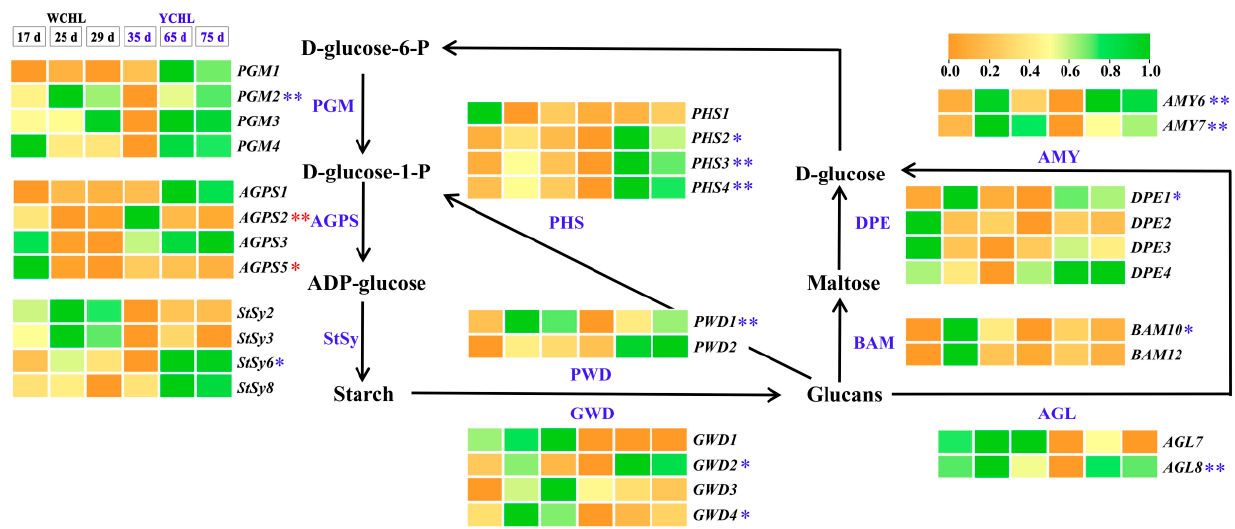
Figure 7. The transcript abundance of candidate genes involved in the proposed starch synthesis and degradation pathways during fruit maturation of ‘WCHL’ and ‘YCHL’ pitayas. Gene abbreviations are shown in Table S5. The correlation analyses of starch content and gene expressions are labeled as * ( p < 0.05, two-tailed) or ** ( p < 0.01, two-tailed), red indicates positive relationship while blue is negative.